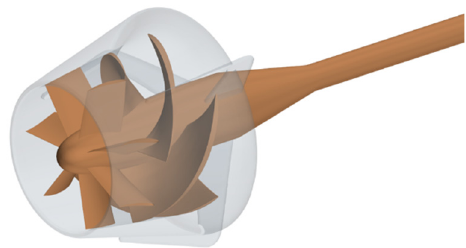
Figure 2. The geometry of the pump-jet.